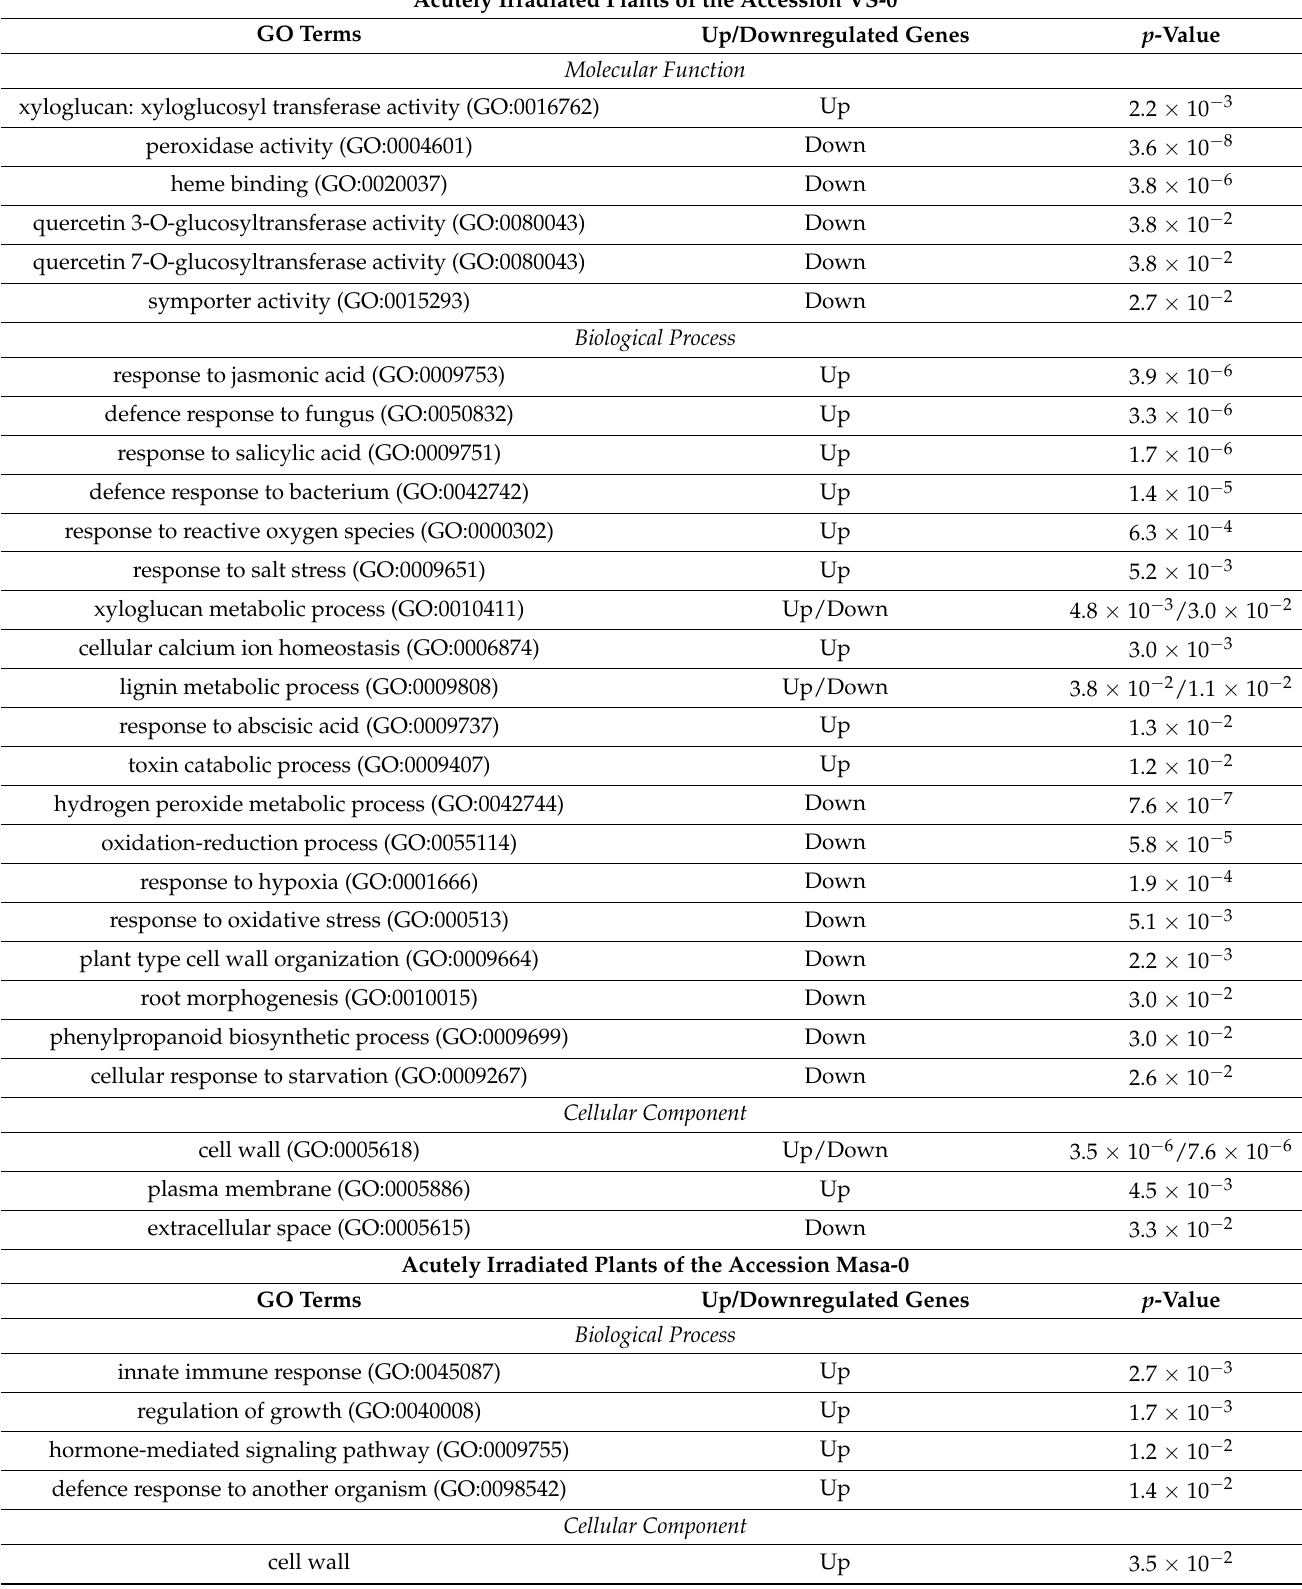
Table 4. Cont. Acutely Irradiated Plants of the Accession VS-0 GO Terms Up/Downregulated Genes p -Value Molecular